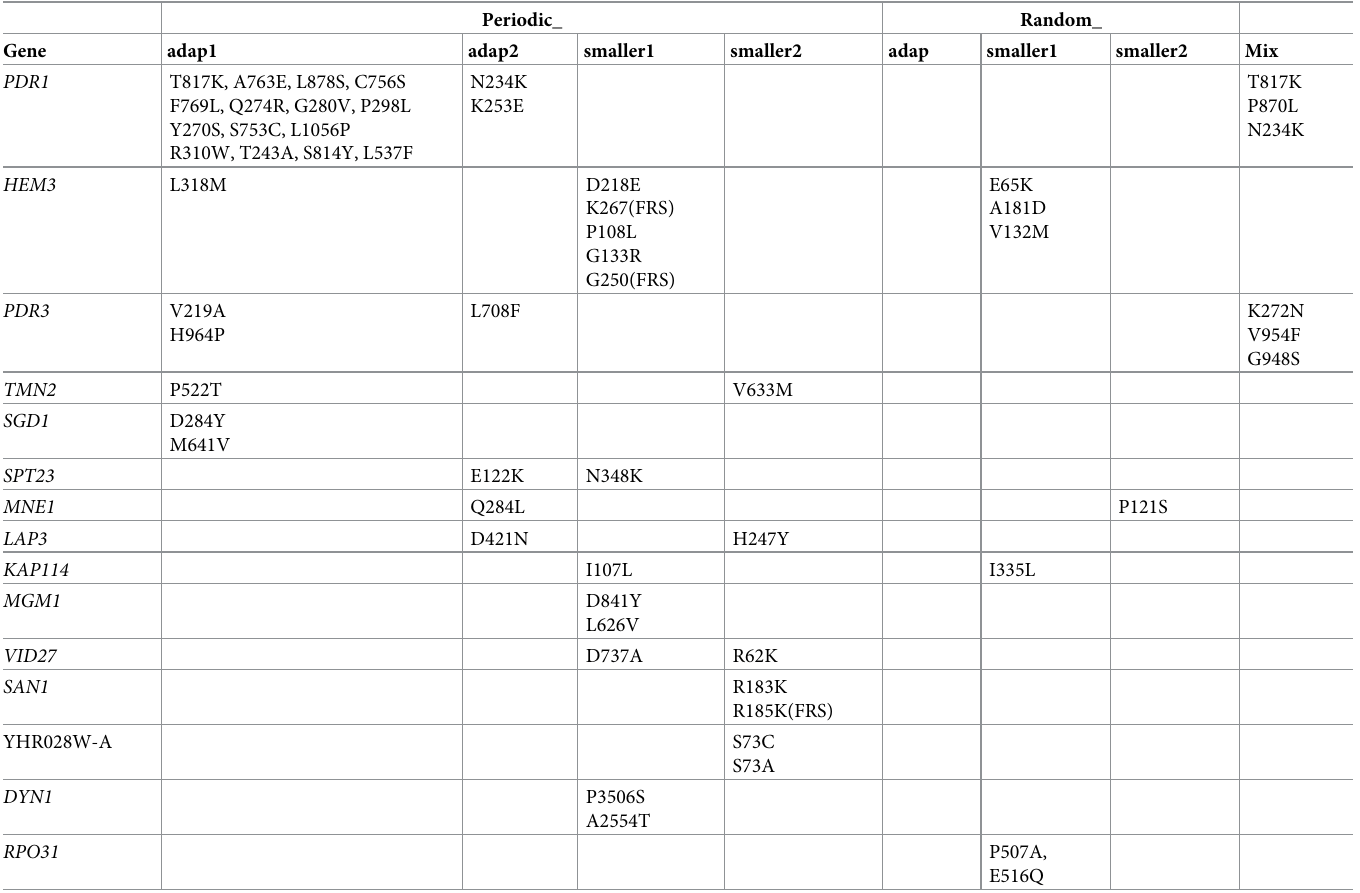
Table 1. Genes mutated at least twice by 2 different non-synonymous mutations (FRS =